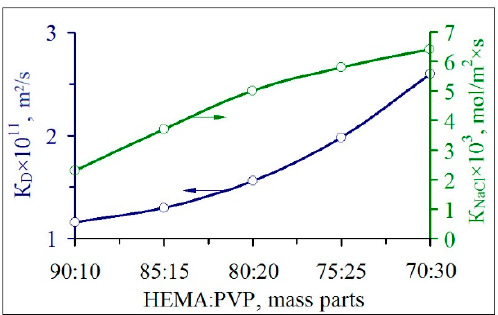
Figure 6. Dependence of diffusion coefficients (K D ) and ion permeability (K NaC l) of hydrogels on the initial composition formulation.